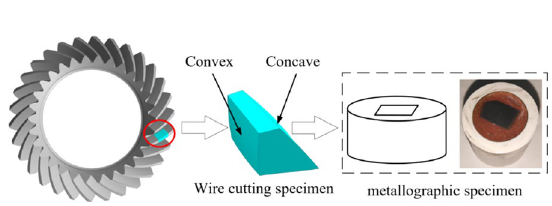
Figure 4 Schematic diagram of metallographic specimen